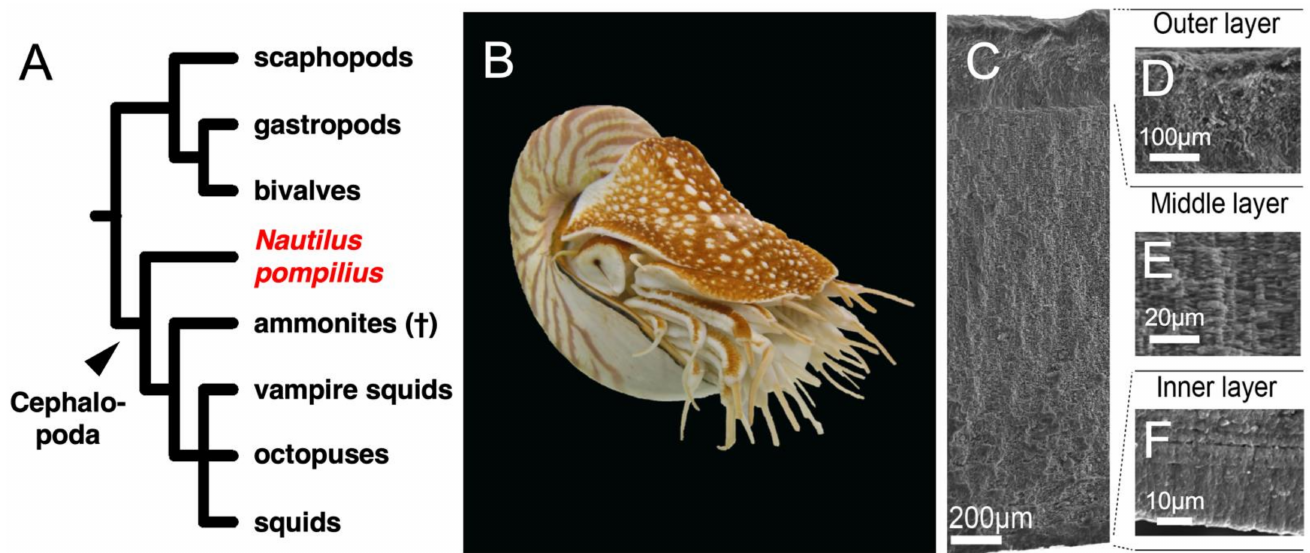
Figure 1. ( A ) Phylogeny of Conchiferans including Nautilus pompilius . ( B ) N. pompilius. ( C ) The microstructures of the shell of N. pompilius . In detail: ( D ) Outer prismatic layer, ( E ) Middle prismatic layer and ( F ) Inner prismatic